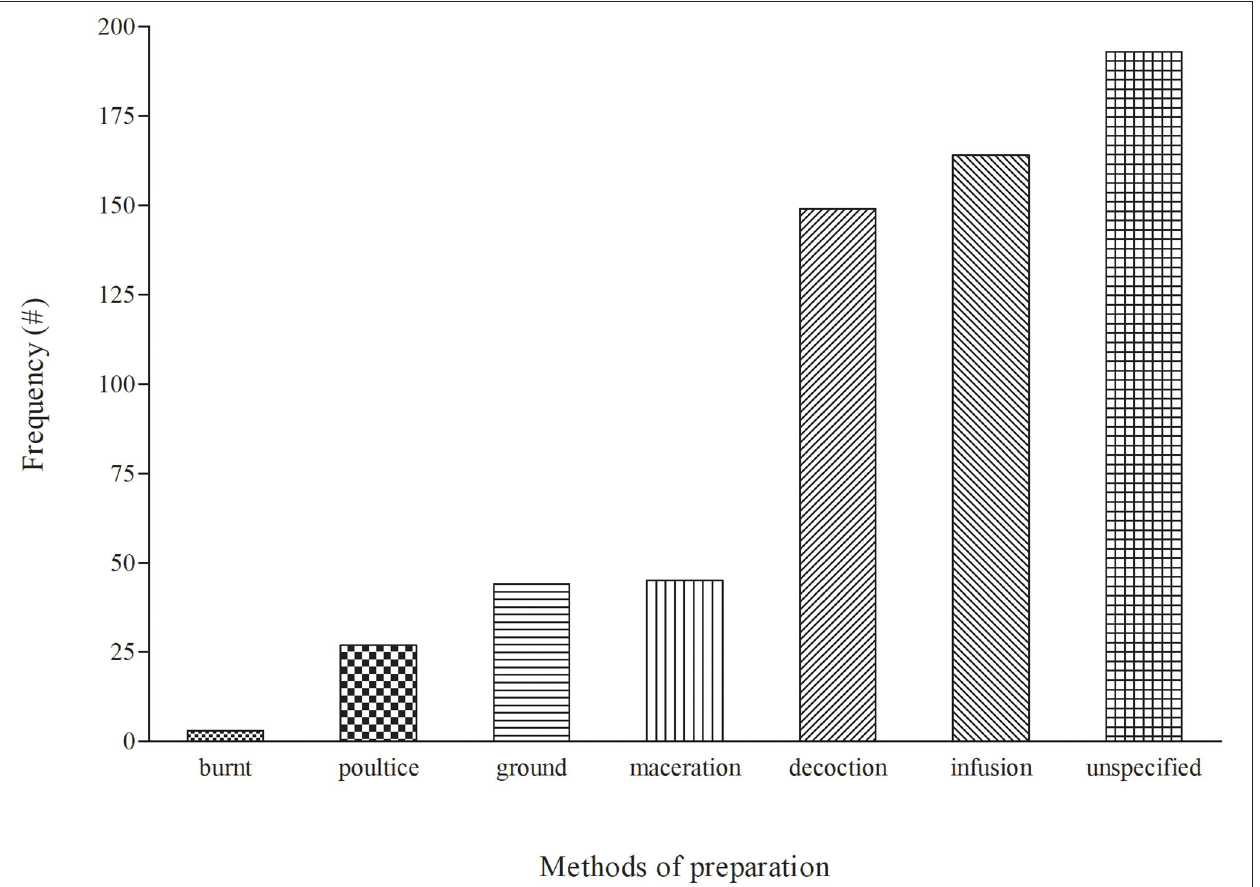
FIGURE 4 | Distribution of the modes of preparation for medicinal plants used to treat cattle diseases in South